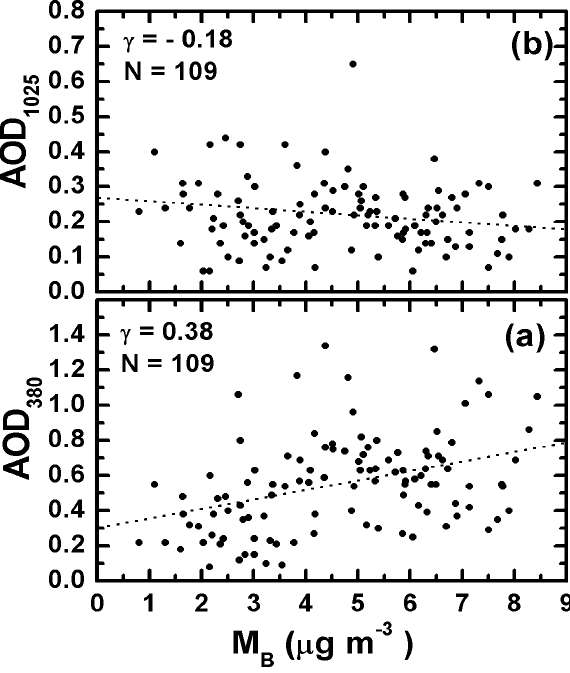
Fig. 10. Scatter plot showing the variation of aerosol optical depth Figure 10. Scatter plot showing the variation of aerosol optical depth (AOD) with black carbon (AOD) with black carbon mass concentration ( M B ) at (a) 380nm and (b) 1025nm. Here N is the number of days on which simul- mass concentration (M ) at (a) 380 nm and (b) 1025 nm. Here N is the number of days taneous observation of spectral AOD and M B is available and γ is B the correlation